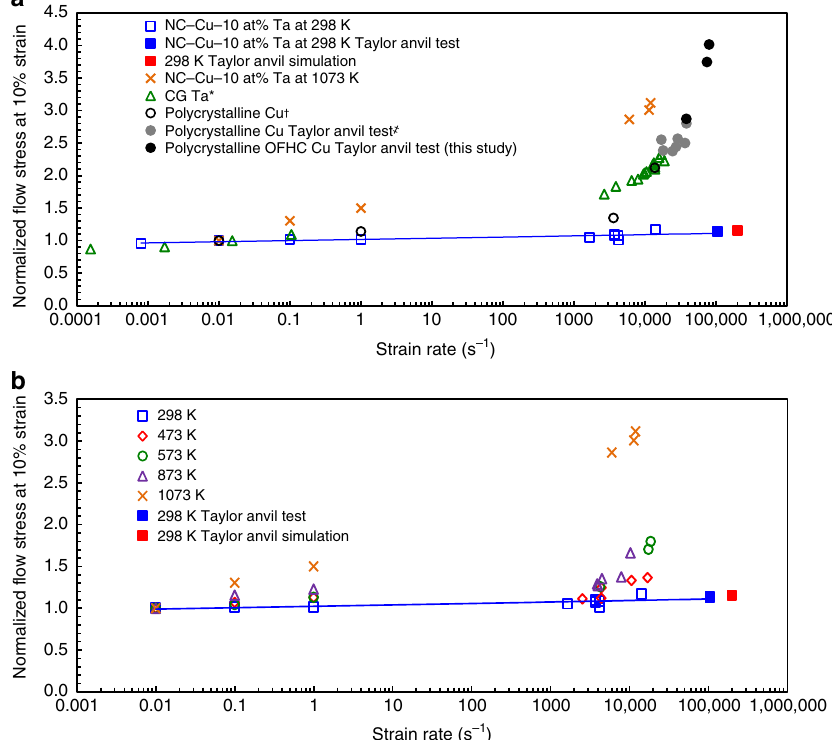
Fig. 1 Normalized fl ow stress as a function of strain rate and temperature. a NC-Cu-10 at.%Ta under ambient conditions compared to high-purity Cu and Ta where *, † , and ҂ refer to the results of coarse-grained Ta from ref. 3 , coarse-grained pure Cu from 9 , and coarse-grained oxygen-free high-conductivity (OFHC) Cu tested by Taylor anvil experiment from ref. 16 , respectively. b NC-Cu-10 at.% Ta at varying testing temperatures. The fl ow stress at a 10% plastic strain level was taken for each strain rate and normalized by the fl ow stress at 10 − 2 s − 1 . Data above 10 4 s − 1 (solid symbols) was approximated using Taylor anvil experiments. The power law fi t for the Cu-10 at.% Ta data reveals that the material is subjected primarily to thermal activation processes up to a strain rate of at least 10 4 s −